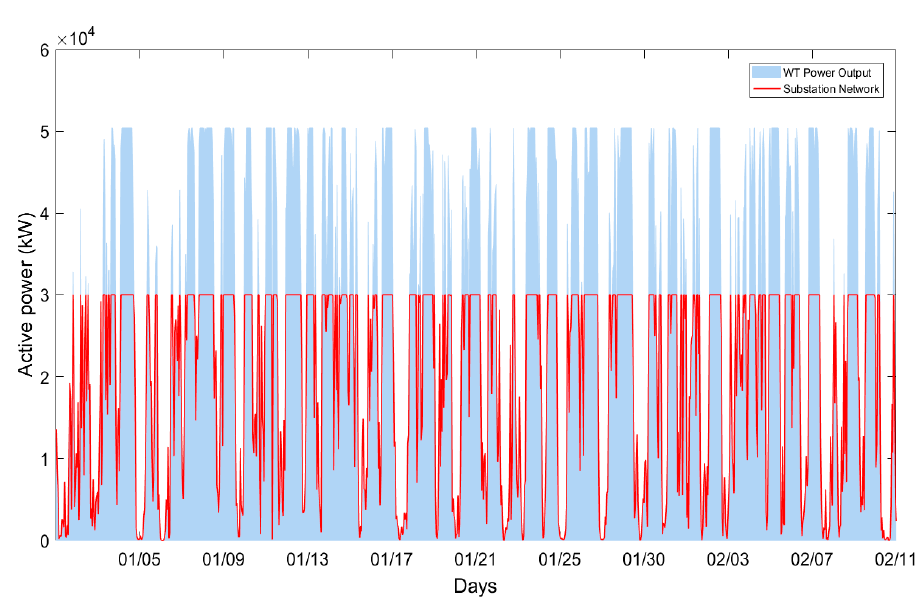
Figure 10. BESS state of charge and active output